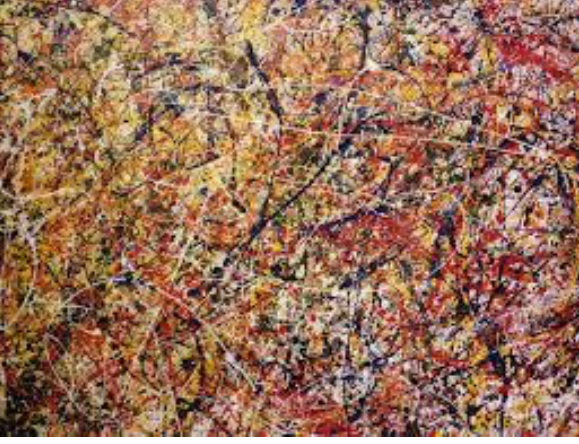
Figure 10 | Jackson Pollock, Drip Painting, 1951.